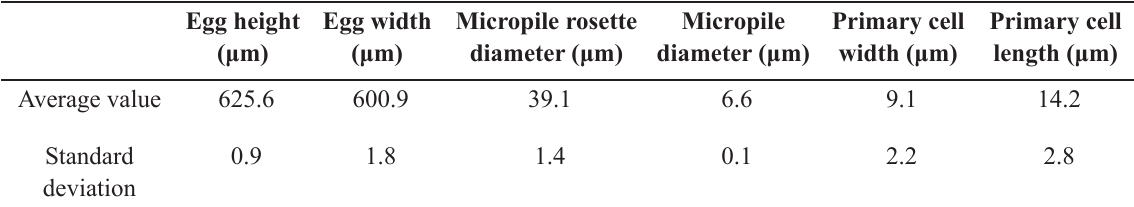
Table 1. Measurements of the egg of M. mimetica Higgins, 1940.